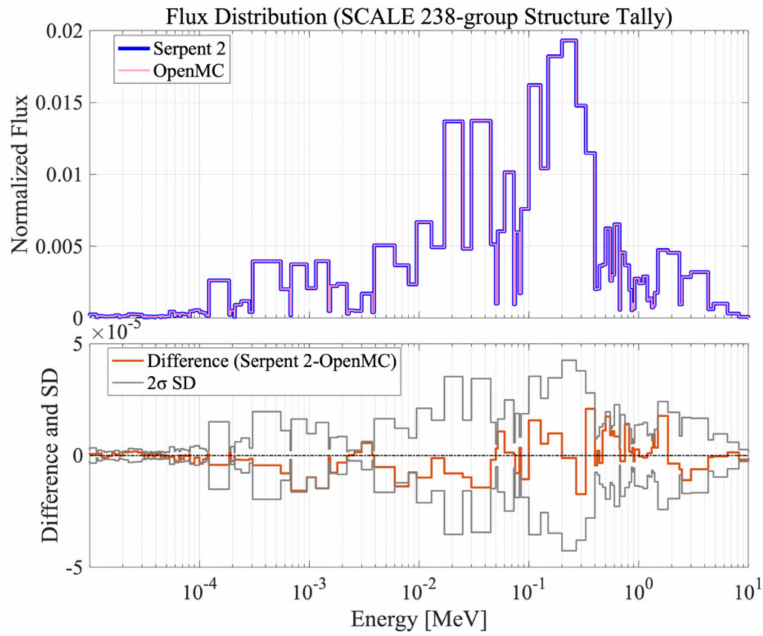
Figure 8. Flux distribution comparison at operation loading with control-rod positions of “2 × RE + 3 × SH + 3 × SA